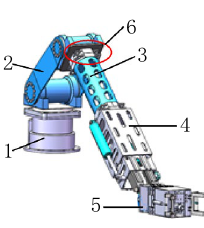
Figure 1. 3D model of the tool-changing robot. 1: Base (the 1st joint), 2: Pitch joint (the 2nd and 3rd joint), 3: Extended arm, 4: Telescopic arm (the 4th joint), 5: End-effector, 6: Quick-change connection